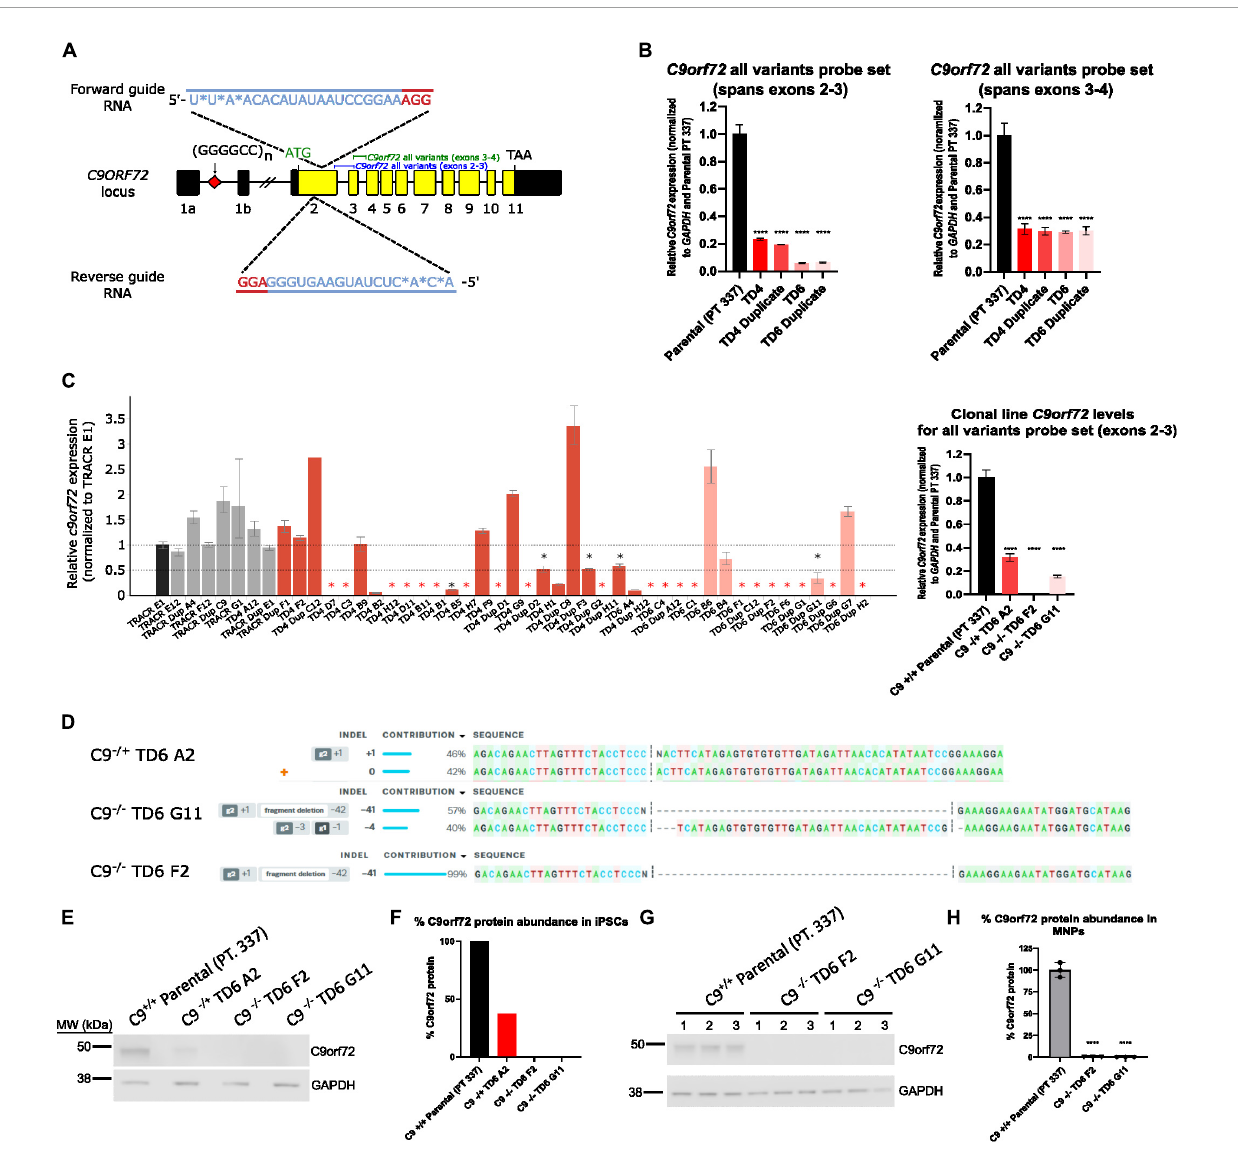
FIGURE1 Generation of hemizygous and homozygous C9orf72 knockout induced pluripotent stem cells (iPSCs). (A) Schematic map of the C9orf72 genomic region and the relative binding positions of forward and reverse sgRNA guides used to introduce an INDEL mutation in exon 2, and TaqMan probe sets used to quantify expression. Diagram modified from Shi et al. (2018). (B) Expression of C9orf72 by quantitative reverse transcription polymerase chain reaction ( qRT-PCR ) in pooled cell populations following Cas9:sgRNA RNP electroporation. Values were normalized to parental cells. ∗∗∗∗ Denotes p < 0.01 (comparing each pooled cell line to the parental pool by one-way ANOVA analysis of variance followed by Dunnett’s test). Data are presented as mean values ± standard deviations (error bars). (C) Expression of C9orf72 by qRT-PCR in a large screen of isolated clonal lines, as well as in a smaller subset of clonal lines that were used in this study. Black asterisk denotes potential heterozygous KO clones, and red asterisk denotes potential homozygous KO clones. (D) ICE analysis of Sanger sequencing of edited exon 2 region. (E) C9orf72 protein levels shown by Western blotting for iPSC clonal lines. (F) Relative quantification of the C9orf72 protein levels shown in (E) . Data are presented as mean values ± standard deviations (error bars). (G) C9orf72 protein levels shown by Western blotting for motor neuron progenitor clonal lines run in triplicate. (H) Relative quantification of the C9orf72 protein levels shown in (G) . C9 − / − TD6 G11 lane three only contains 10 µ g of the total protein (50%) due to insufficient